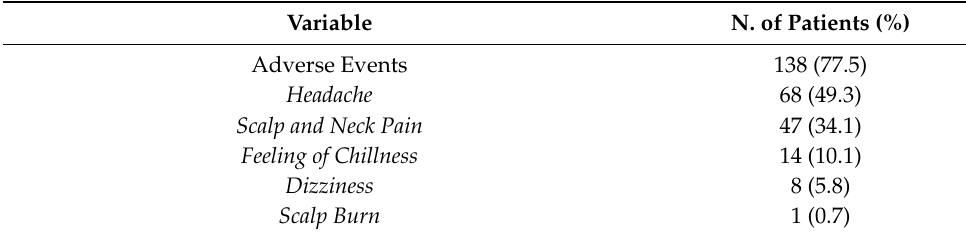
Table 5. The adverse events of the scalp cooling